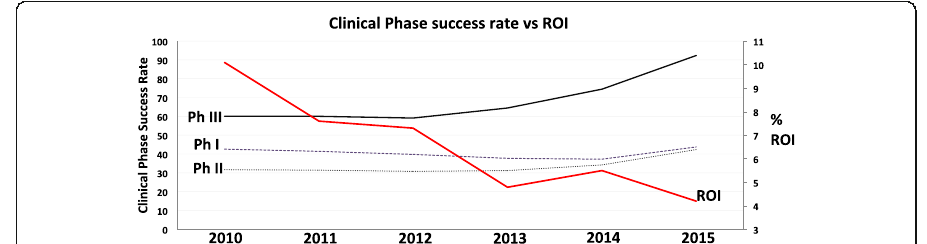
Fig. 2 Clinical trial rates for CVD vs generic ROI: Phase III clinical trial success rates have increased, but this has not been reflected in the ROI . Da ta for CVD success rates from 2010 to 2015 were obtained from Wong et al. (2018) and plotted against industry wide ROI on R&D figures obtained from Deloitte